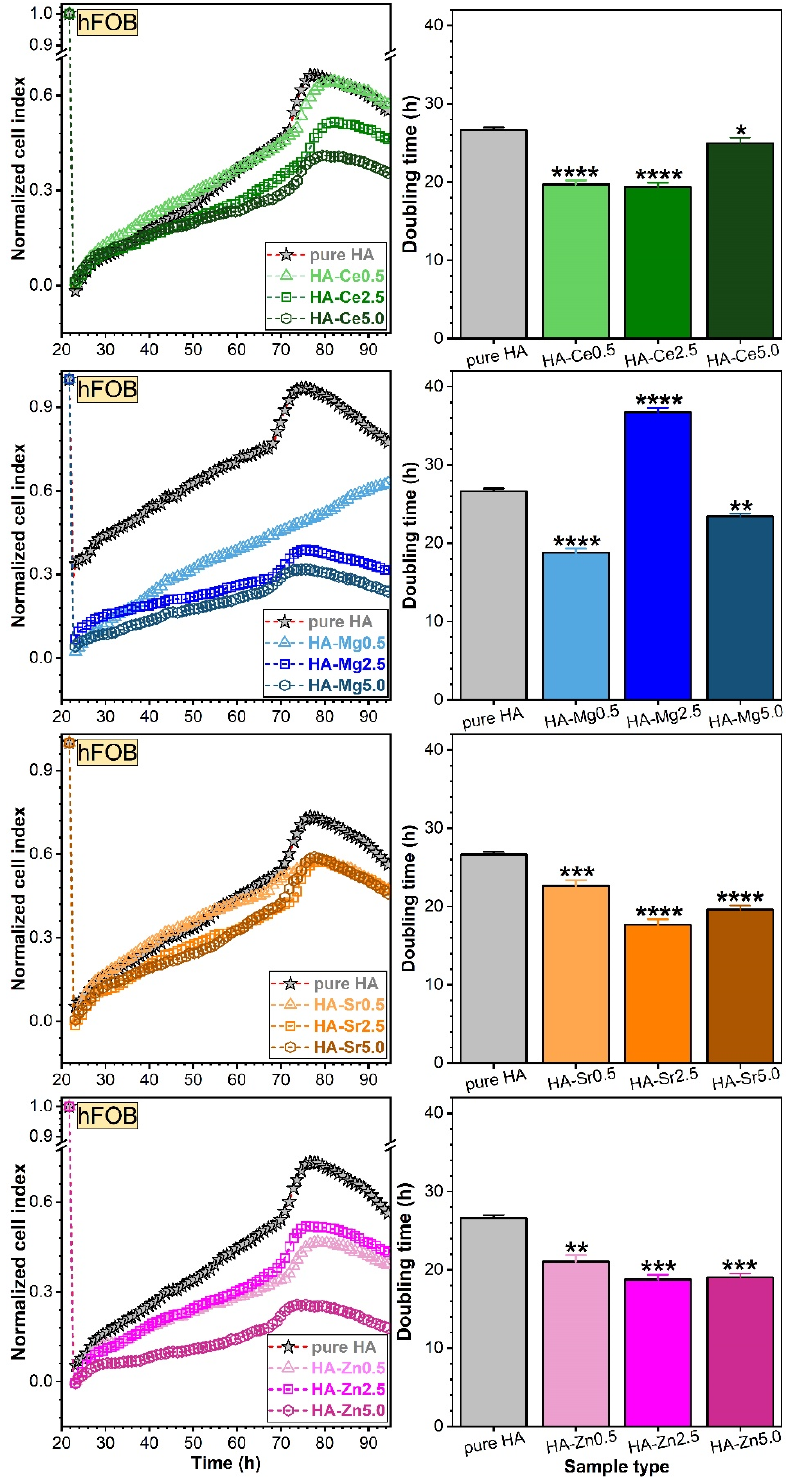
Figure 14. Impedance changes of the RTCA system mirroring the proliferation of hFOB cells in the presence of pure HA and Ce-, Mg-, Sr-, or Zn-substituted HA ( left panel ). The error bars were not figured as they would have obstructed the good visualisation of the evolution of mean values. The values of the doubling time were plotted as bars ( right panel ). * p < 0.05, ** p < 0.01, *** p < 0.001, and **** p < 0.0001 statistically significant differences with respect to pure HA (taken as control), as determined by using a one-way ANOVA multiple analysis followed by a Dunnett’s post hoc test.